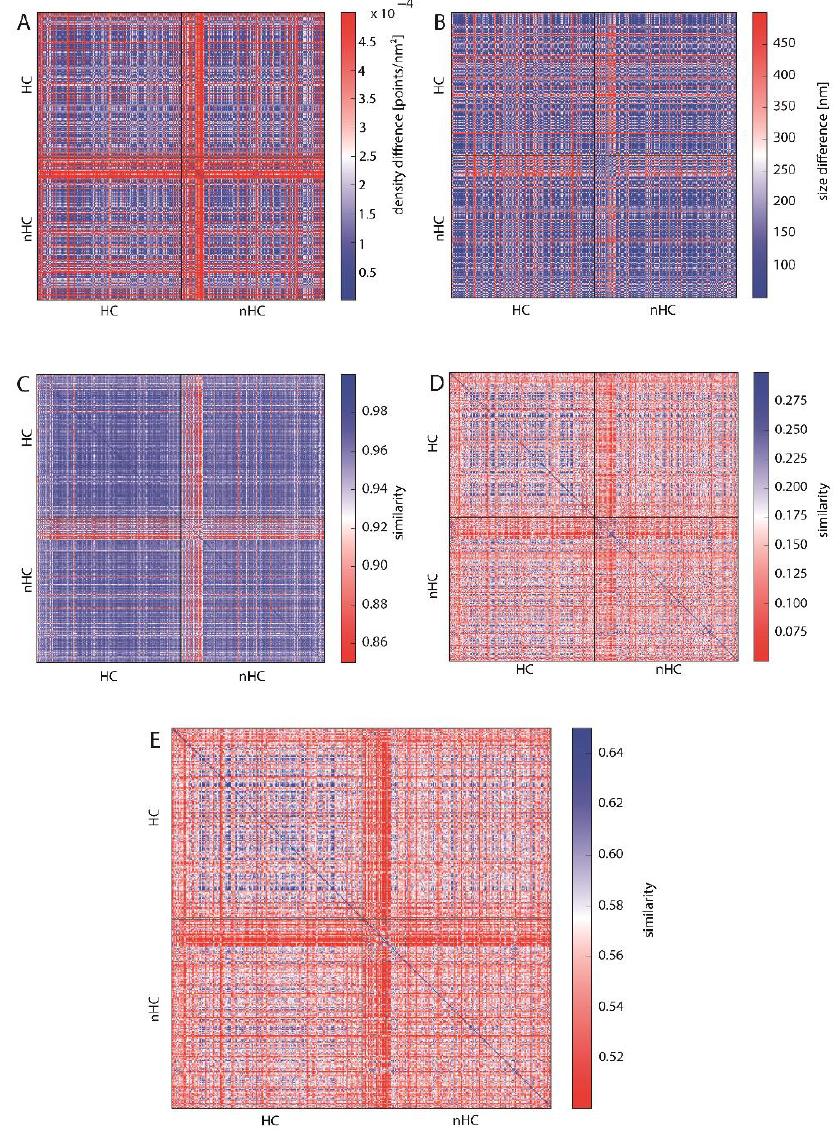
Figure 5. Heat maps depicting the similarity of HC- and nHC-associated γH2AX clusters according to ( A ) cluster density, ( B ) cluster size indicating a high similarity (see also Figure S2), ( C ) topological similarity of the connected components (“lines”), ( D ) topological similarity of the “holes”, ( E ) average topological similarity. The spectrum of the color bar of all the heat maps ranges from red representing dissimilarity between the analyzed clusters to blue depicting similarity.